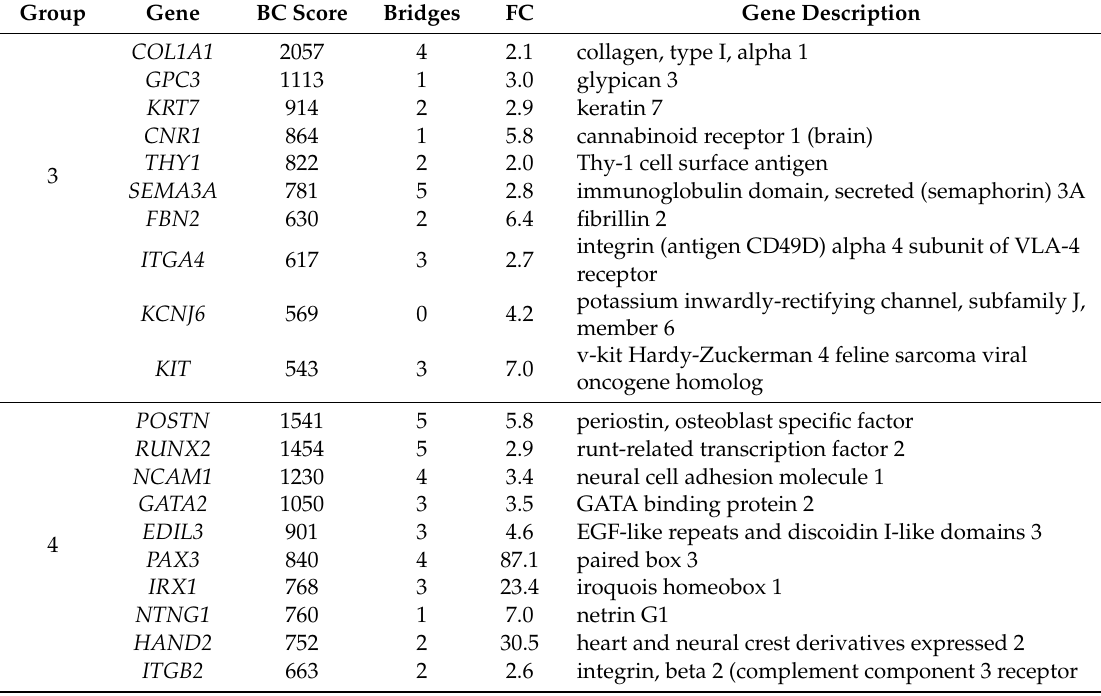
Table 2. Betweenness centrality (BC) score and Bridges number identified based on STRING Interactome networkanalysisbyIgrapgRandFoldChanges(FC)identifiedbyDESeqRofthedi ff erentiallyexpressed genes DN vs. SC comparison. Average FC when two data were considered (Groups 3 and 4 respectively), n = 9